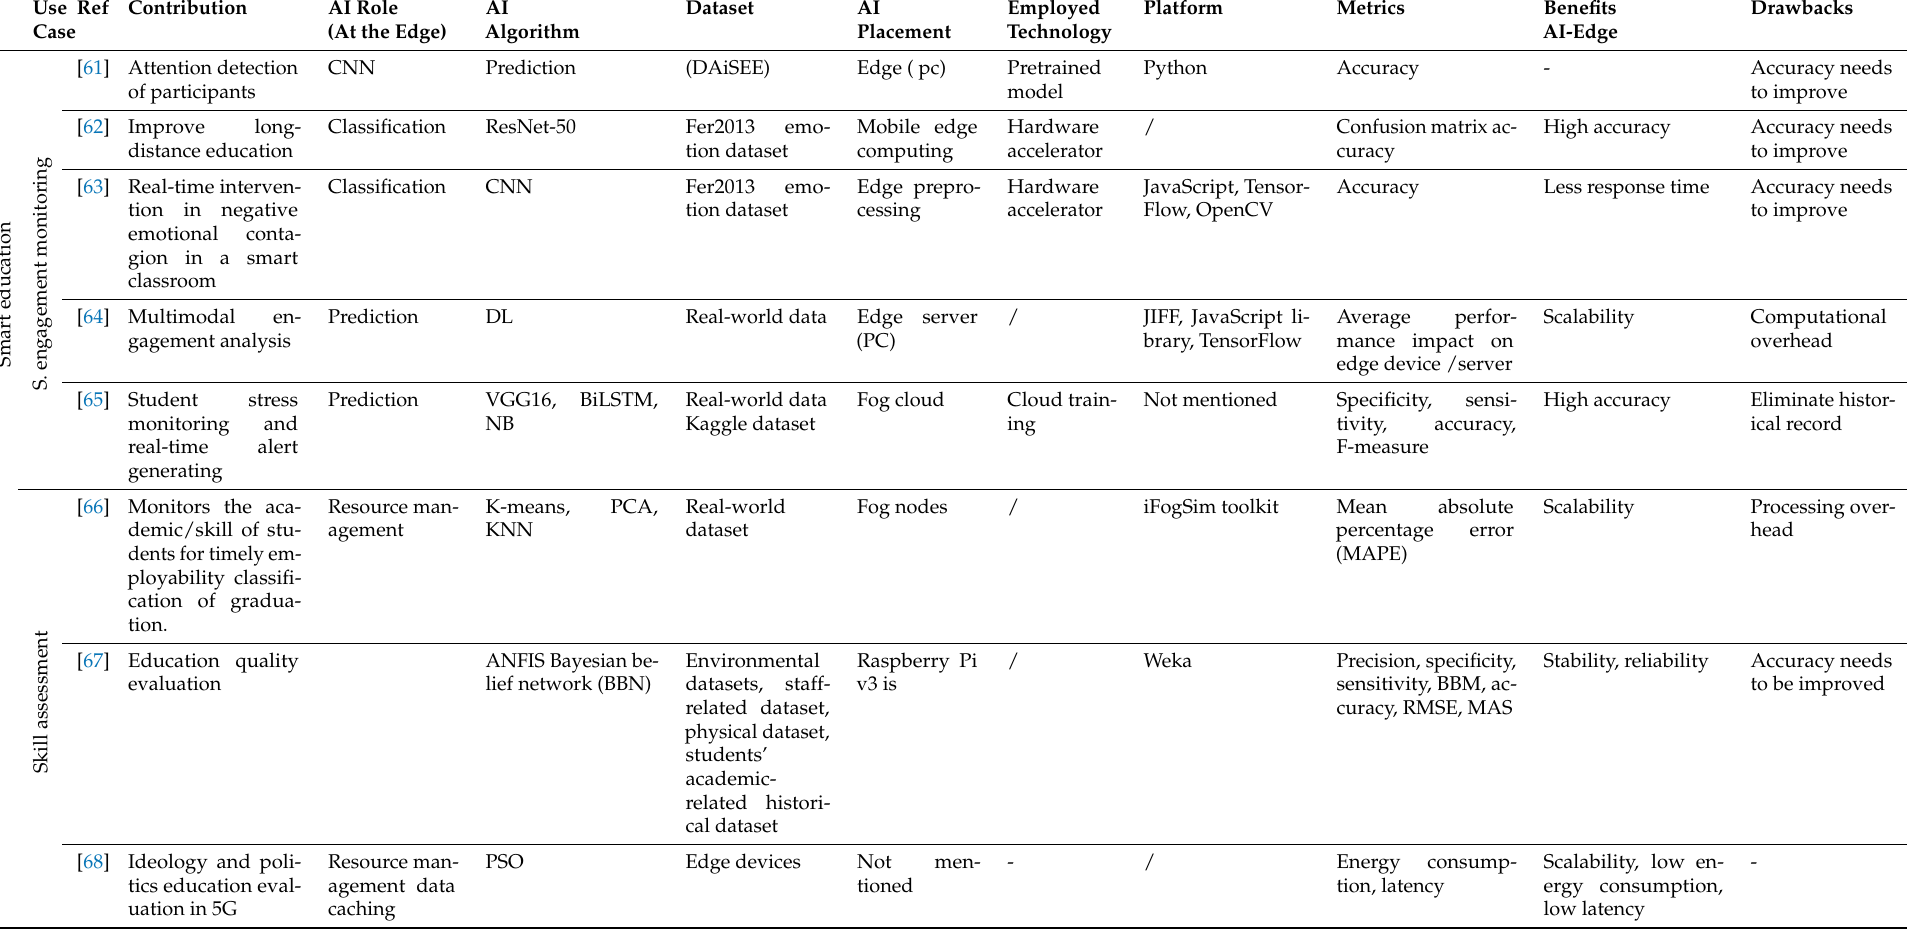
Table 6. Qualitative comparison of smart education related